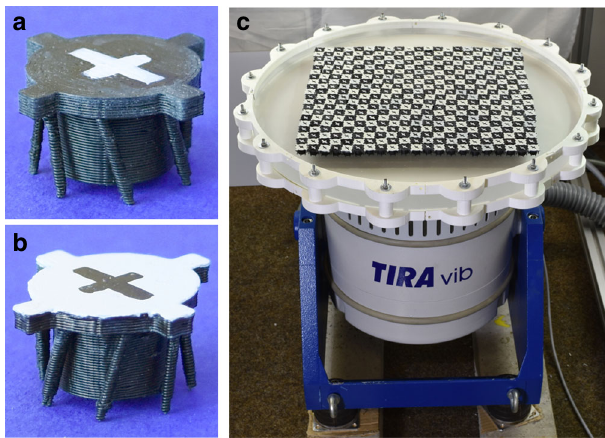
Fig. 1 3D-printed spinning robots and experimental setup. a Clockwise and b counter-clockwise spinning rotors (diameter σ = 15 mm). Four satellites attached to the edge of the body enhance steric interactions between particles. c Electromagnetic shaker with circular acrylic baseplate and smooth circular enclosing ring (diameter 470 mm). Initially, the rotors are placed in a checkerboard con fi guration with alternating clockwise and counter-clockwise spinning